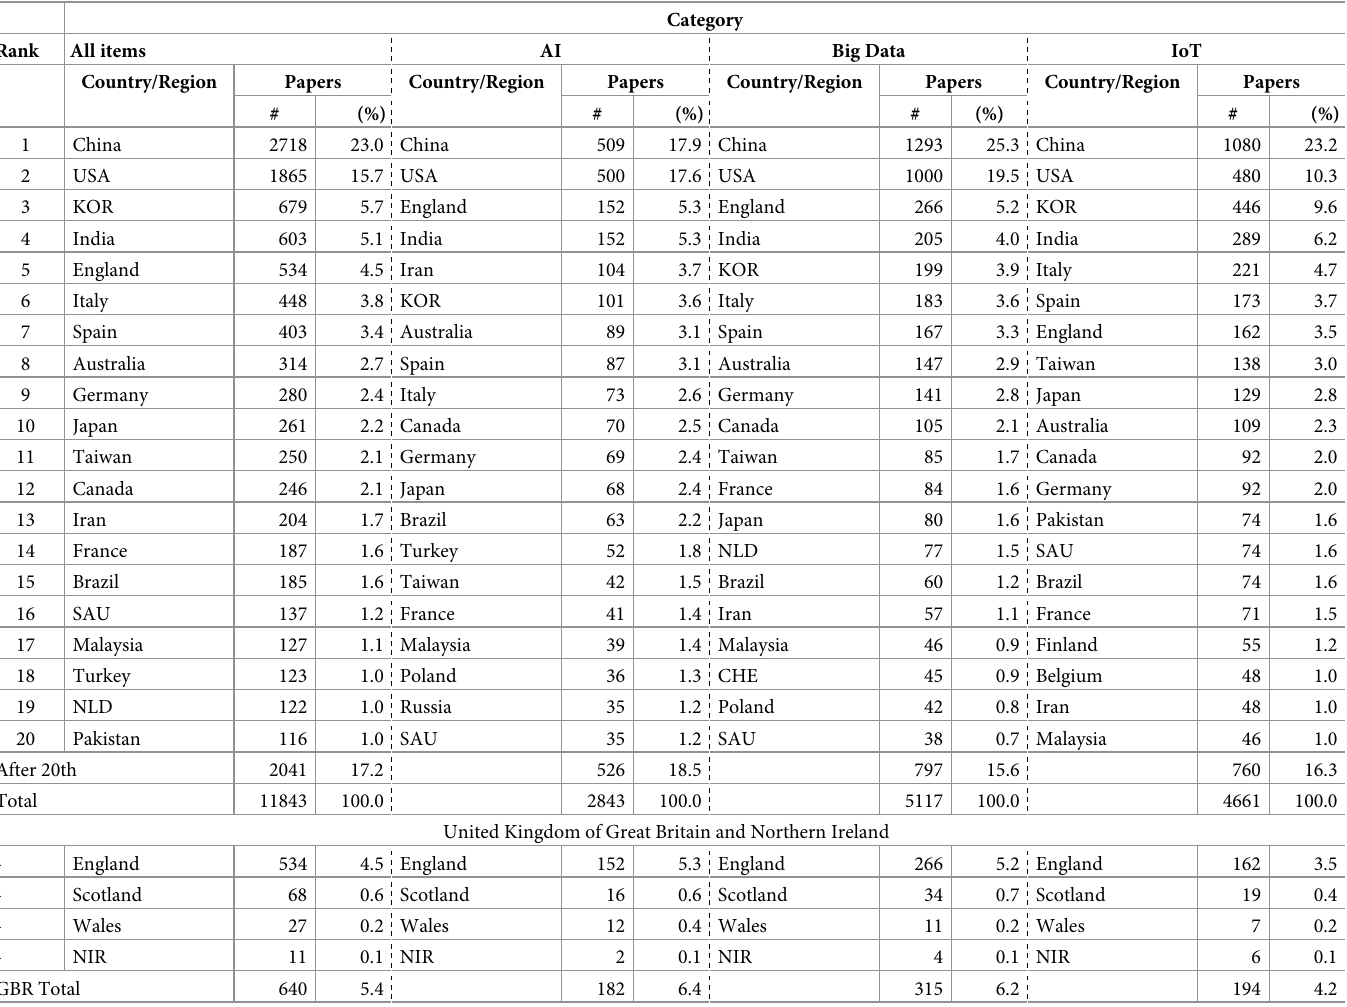
Table 1. Top 20 countries for related papers on artificial intelligence, big data, and internet of things